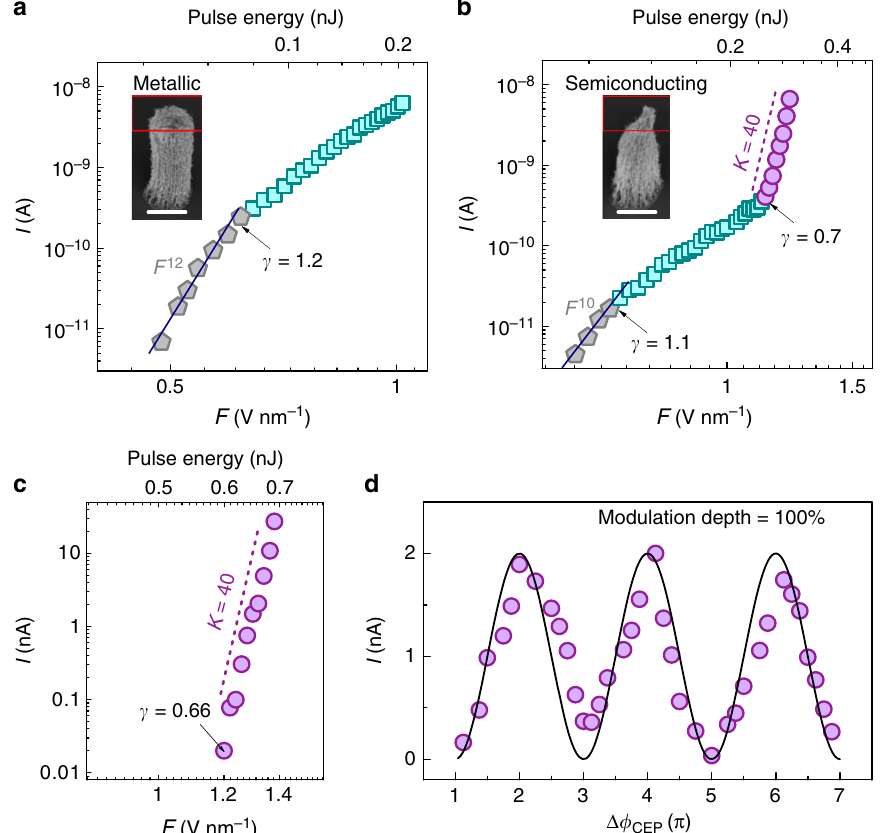
Fig. 2 Extreme nonlinear OFE current. a Experimentally obtained log – log plot of optical- fi eld ( F ) dependent total photoemission current ( I ) for a CNT cluster before aging, driven by 100-fs laser pulses with a central wavelength of 820 nm. Two linear behaviors are observed, as shown by different colors: multiphoton photoemission (MPP) (gray pentagonal dots); OFE (green square dots). The inset shows the scanning electron microscopy (SEM) image of the emitter. Scale bar is 2 μ m. b I – F curve of aged CNT cluster in which the metallic tubes have been removed. Three linear behaviors are observed: MPP (gray pentagonal dots); CB-OFE (green square dots); VB-OFE (purple circular dots). An extremely high slope of K = 40 (dashed line) was observed. The inset shows the SEM image of the emitter. Scale bar is 2 μ m. c CEP-stabilized measurement of the I – F curve of the same emitter, by using 7-fs few-cycle laser pulses centered around 800 nm. A slope of K = 40 is obtained as well. d The CEP-dependent photoemission current at a fi xed laser intensity with a peak F = 1.3 V nm − 1 with a cosine fi t (solid